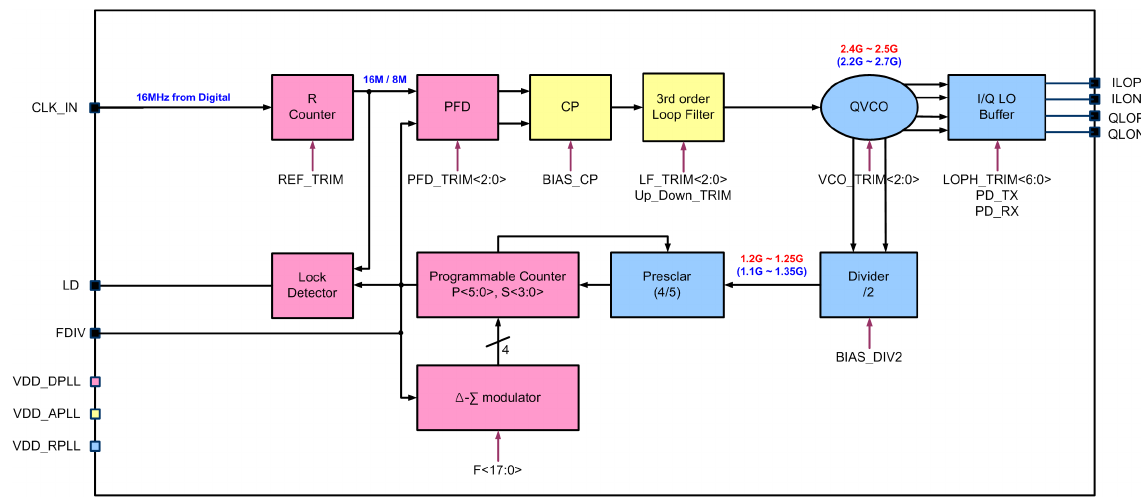
Figure 5. Frequency synthesizer